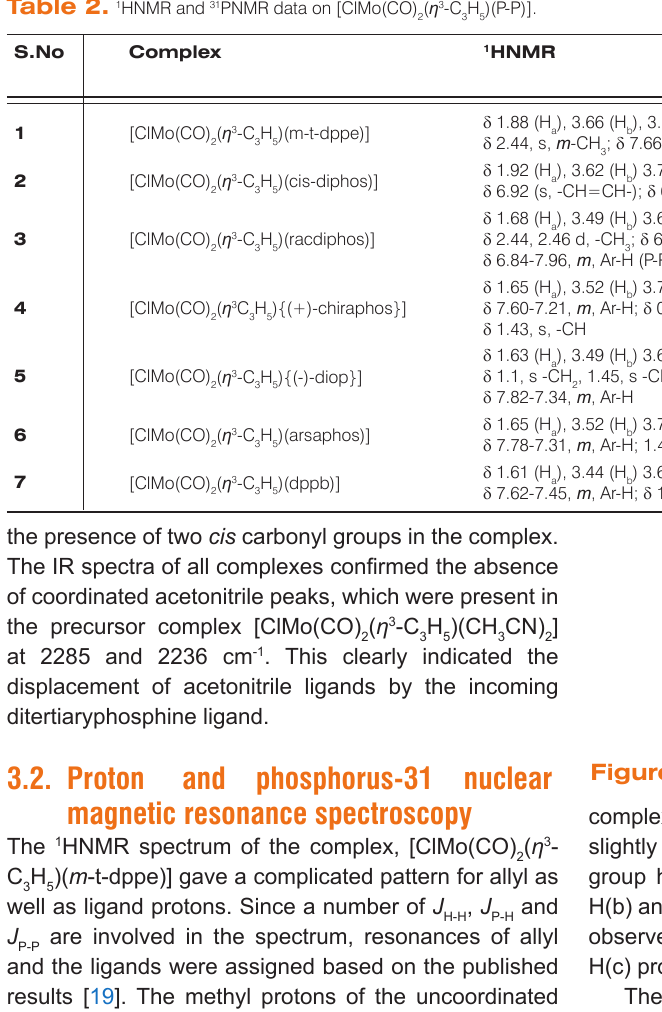
Table 1. Selected FTIR and force constant data on [ClMo(CO)